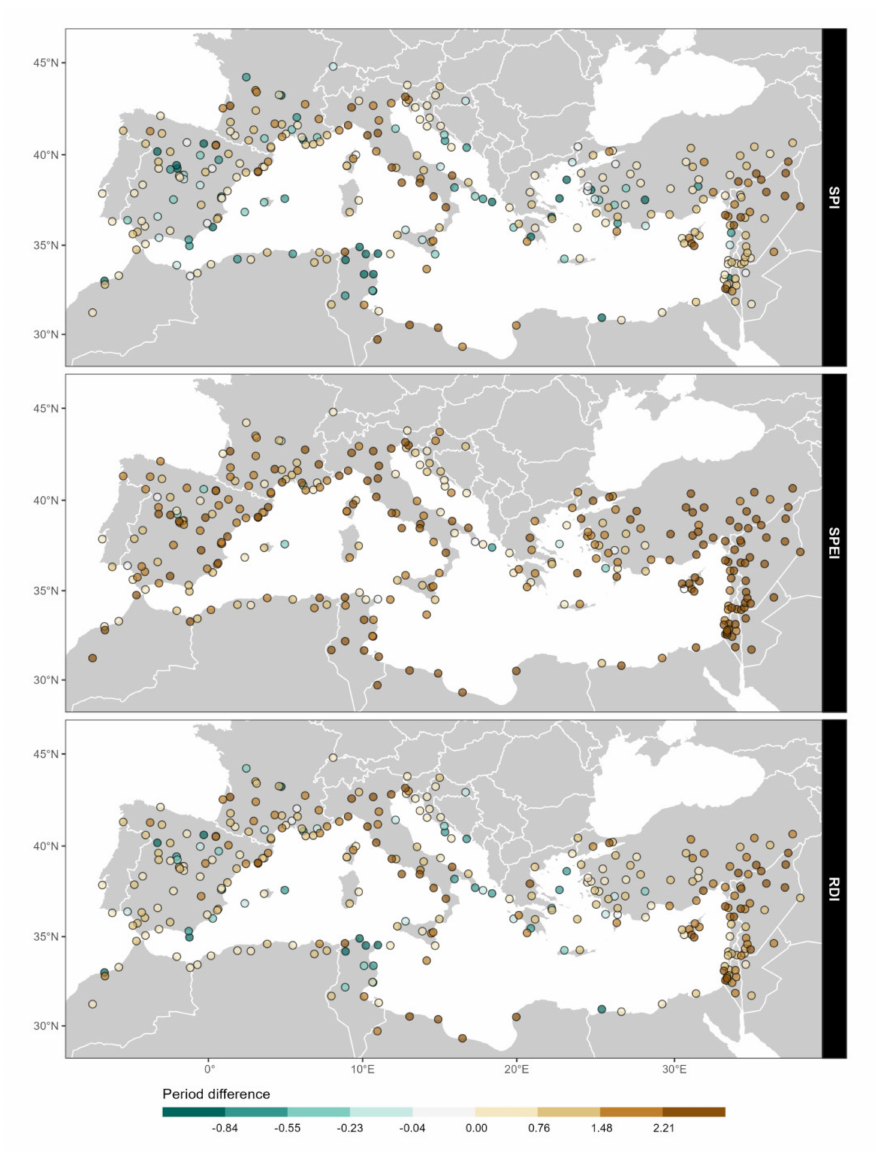
Figure 7. Drought frequency identified by SPI-12 (upper map), SPEI-12 (middle map) and RDI-12 (lower map) between 1975–1996 and